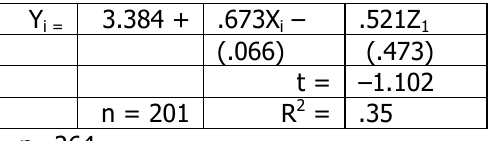
Index of Empathy – Regression Results, Coefficients (Standard Error)